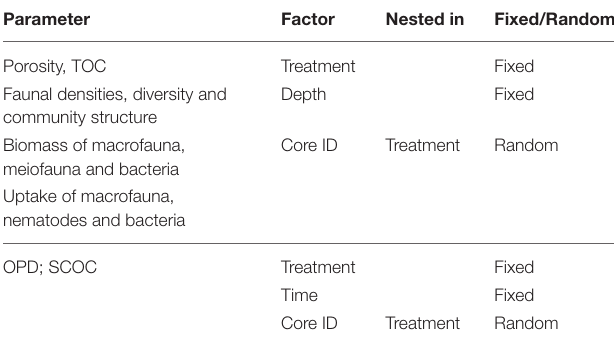
TABLE 1 | Permanova designs for the analysis of various parameters. Parameter Factor Nested in Fixed/Random Porosity, TOC Treatment Fixed Faunal densities, diversity and Depth community structure